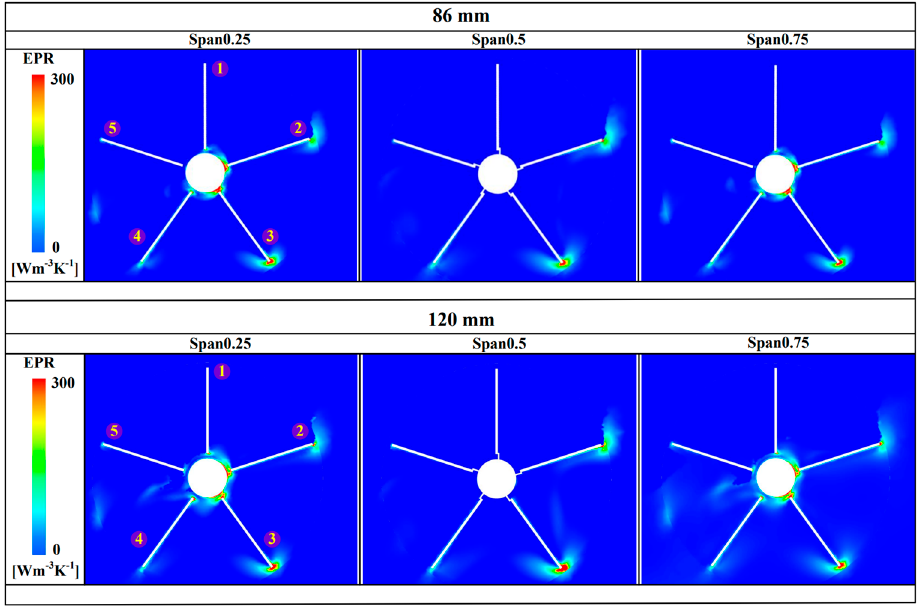
Figure 14. Distribution of EPR in the midsection of water wheels under 86 mm and 120 mm clearances.